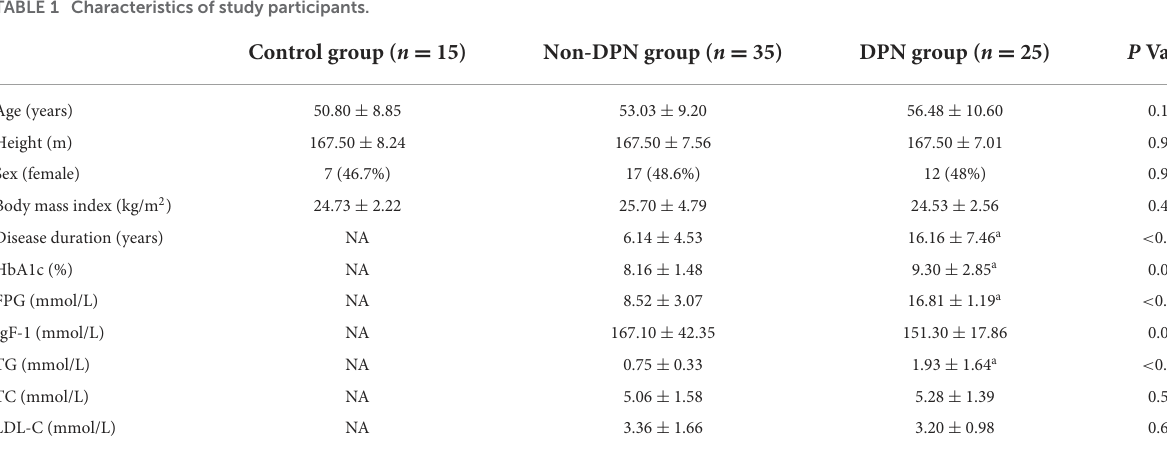
TABLE 1 Characteristics of study